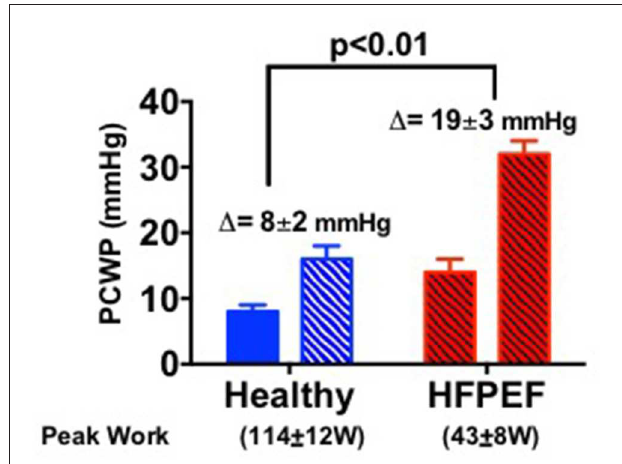
FIGURE 2 | Bar graphs show the pulmonary capillary wedge pressure (PCWP) response to exercise in healthy people and in HFpEF patients [adapted from van Empel et al. ( 26)].